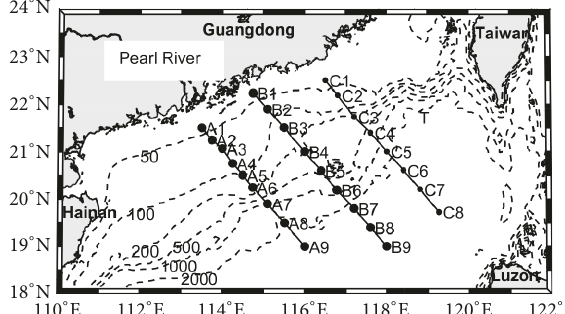
Figure 1: Spatial distribution of shipboard CTD observations during the open cruises. Some sites were not measured in each year due to the actual investigation plan and in some cases bad weather